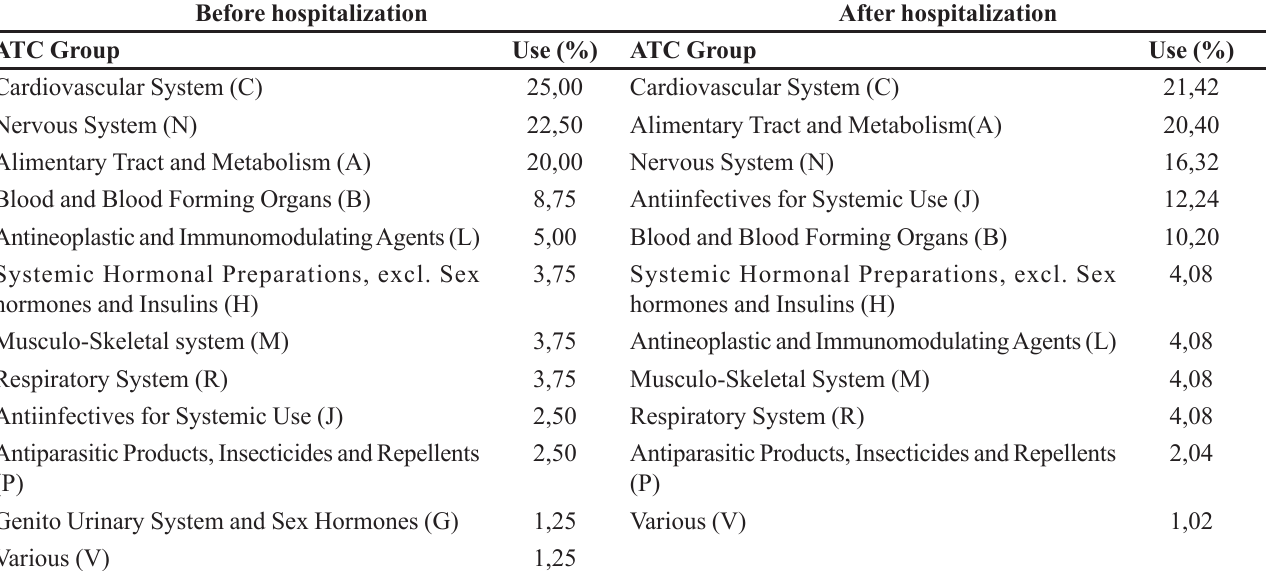
TABLE I - Percentage of use of each therapeutic group before and after hospitalization, Niteroi, 2012, N=260